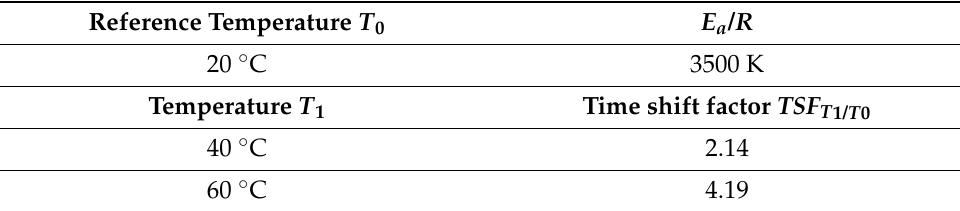
Table 7. Time shift factors determined from the experimental results at 20 °C, 40 °C and 60 °C.